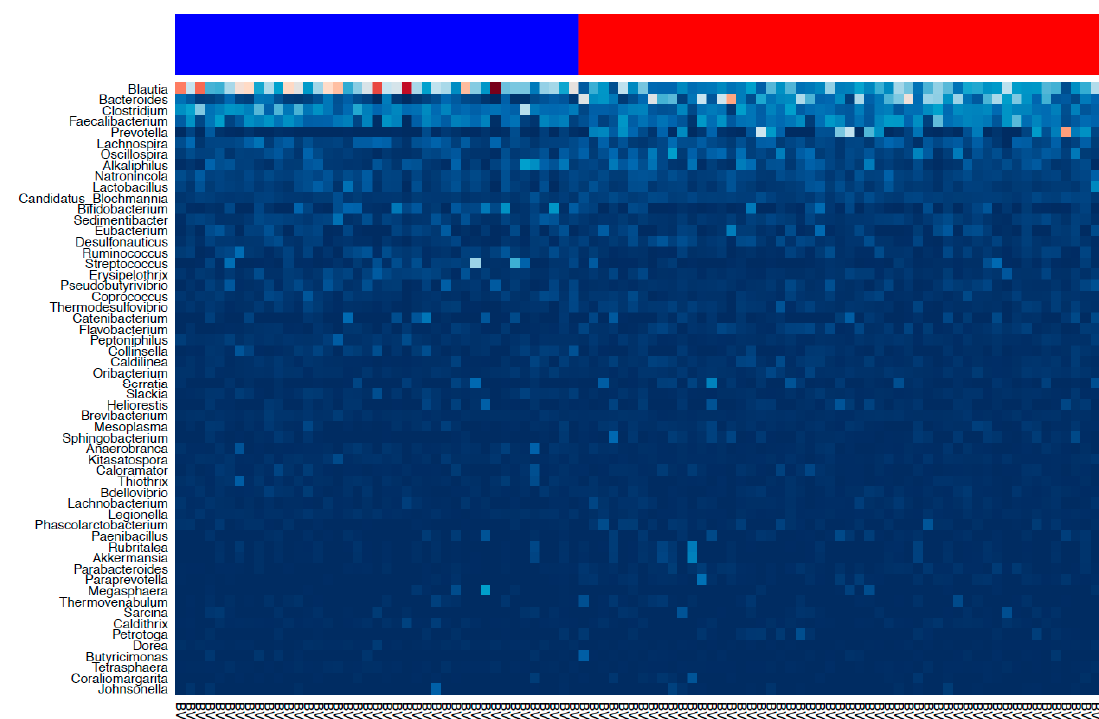
Figure 2. Heatmap of the genus-level taxonomic composition (only the major genera forming 85% of